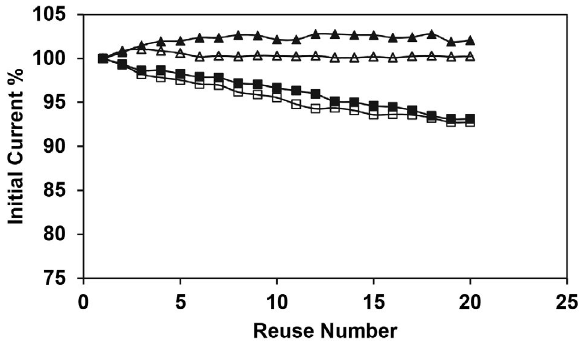
Figure 9. Operational stabilities of enzyme electrodes GOD-Chi/ POA/Pt (  ), ZnONP-GOD-Chi/POA/Pt (  ), GOD-Chi/PPy/Pt (  ) and ZnONP- GOD-Chi/PPy/Pt ( 